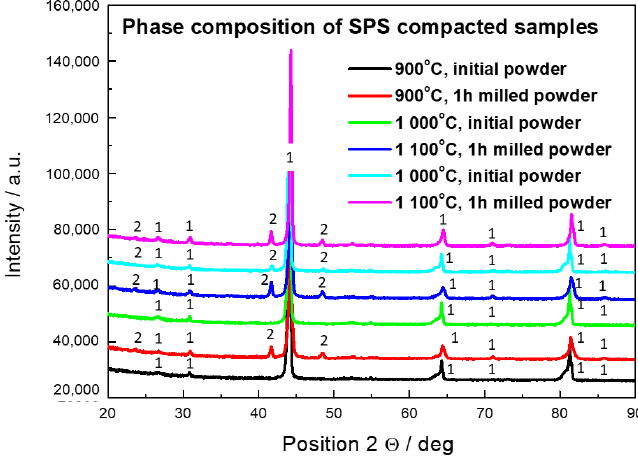
Figure 5. XRD di ff raction pattern of SPS compacted Fe28Al from initial powder sintered at 900 ◦ C, Figure 5. XRD diffraction pattern of SPS compacted Fe28Al from initial powder sintered at 900 °C, 1000 ◦ C, and 1100 ◦ C and from 1-h milled powder sintered at 900 ◦ C, 1000 ◦ C, and 1100 ◦ C, 1—D0 3 1000 °C, and 1100 °C and from 1-h milled powder sintered at 900 °C, 1000 °C, and 1100 °C, 1 – D0 3 FeAl, 2—Fe 3 AlC FeAl, 2 – Fe 3 AlC 0.5.